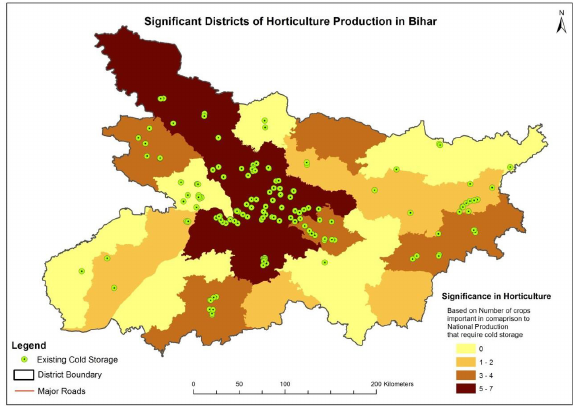
Figure 5. Significant Horticulture districts and existing cold storage distribution in Bihar